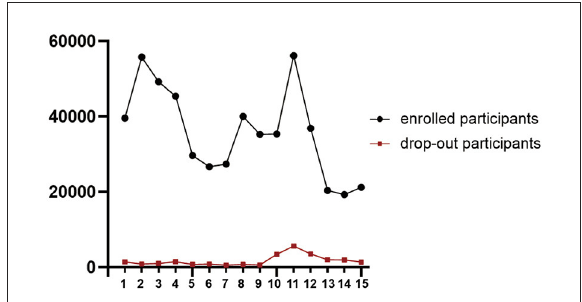
FIGURE1 The number of enrolled and drop-out participants from 1 to 15 semesters.